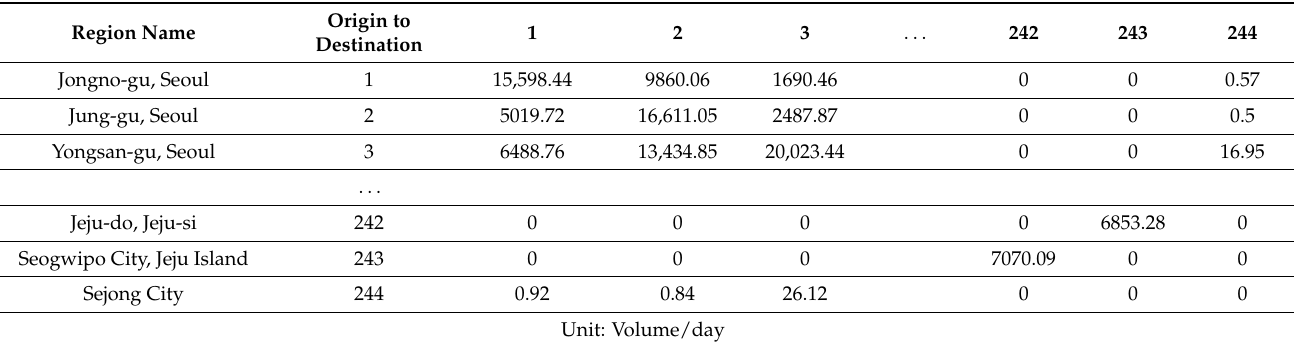
Table 2. Commuter Origin-Destination data sets in